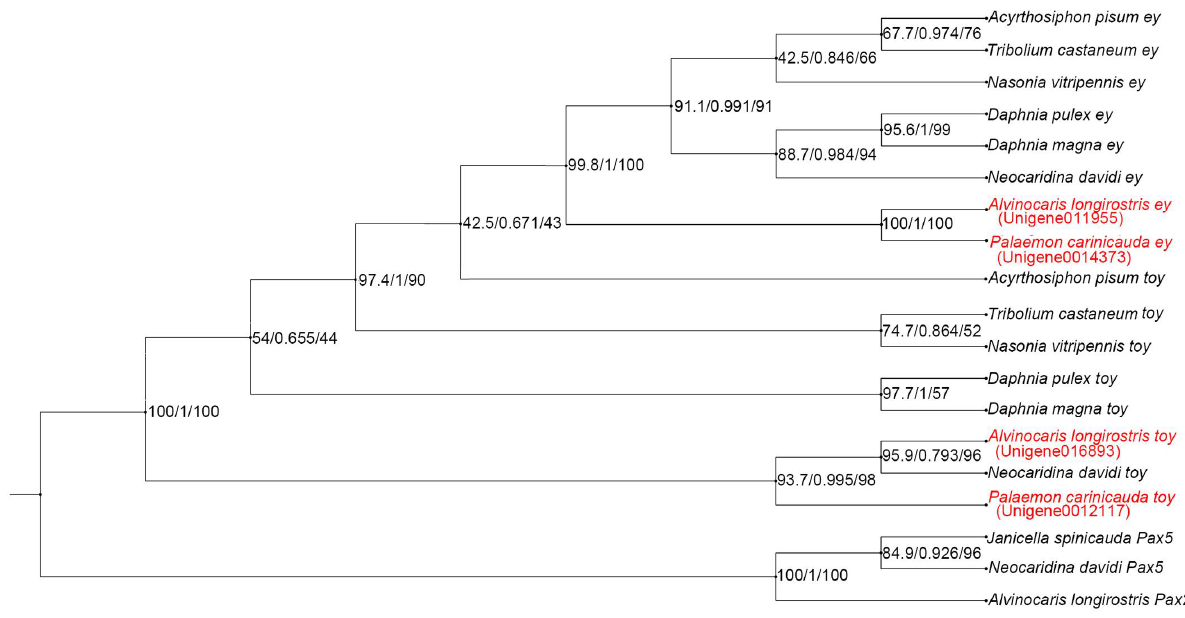
Figure 2. The KOG distribution of annotated genes in the eye transcriptomes of Alvinocaris longirostris and Palaemon carinicauda .